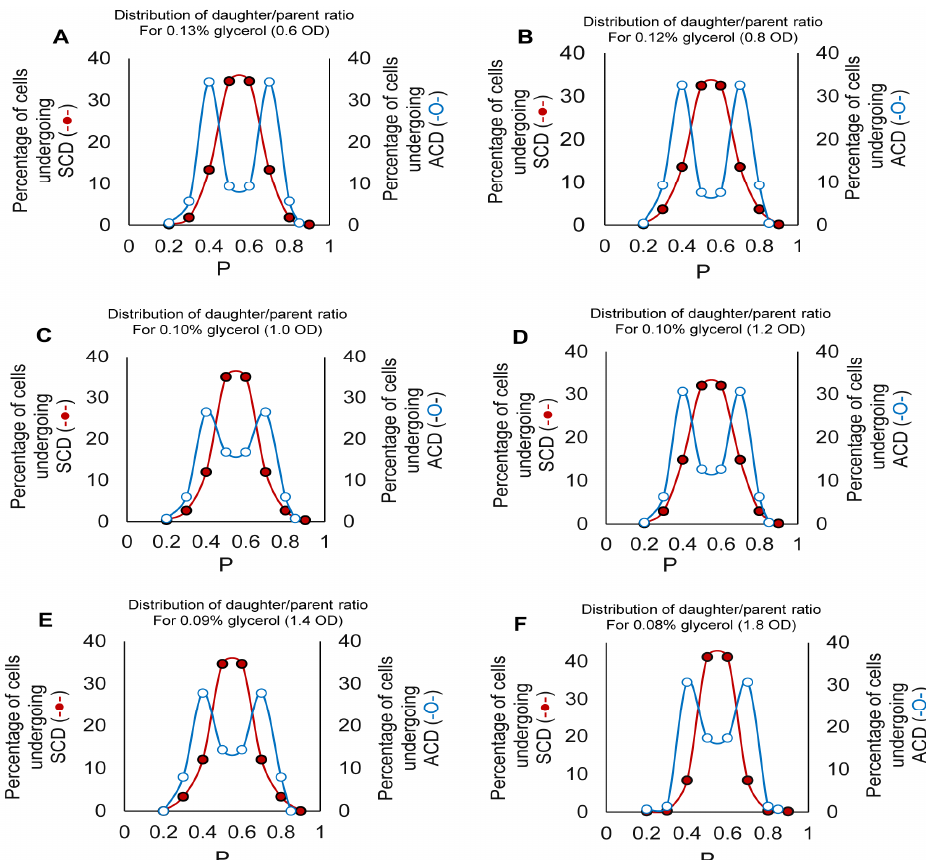
Figure 2. Gaussian distribution of daughter/parent ratio at different glycerol concentrations and OD values of growth. The daughter/parent ratio of distribution in ( • ) SCD and (o) ACD for ( A ) 0.6 OD (MLP), 0.13% glycerol; ( B ) 0.8 OD, 0.12% glycerol; ( C ) 1.0 OD, 0.11% glycerol; ( D ) 1.2 OD, 0.1% glycerol; ( E ) 1.4 OD, 0.09% glycerol; ( F ) 1.8 OD, 0.08% glycerol. The daughter/parent ratio of distribution in SCD shows unimodal and that in ACD shows bimodal distribution.